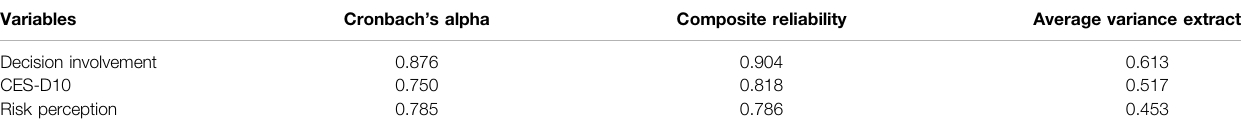
TABLE 1 | Reliability and validity of the survey instrument. Variables